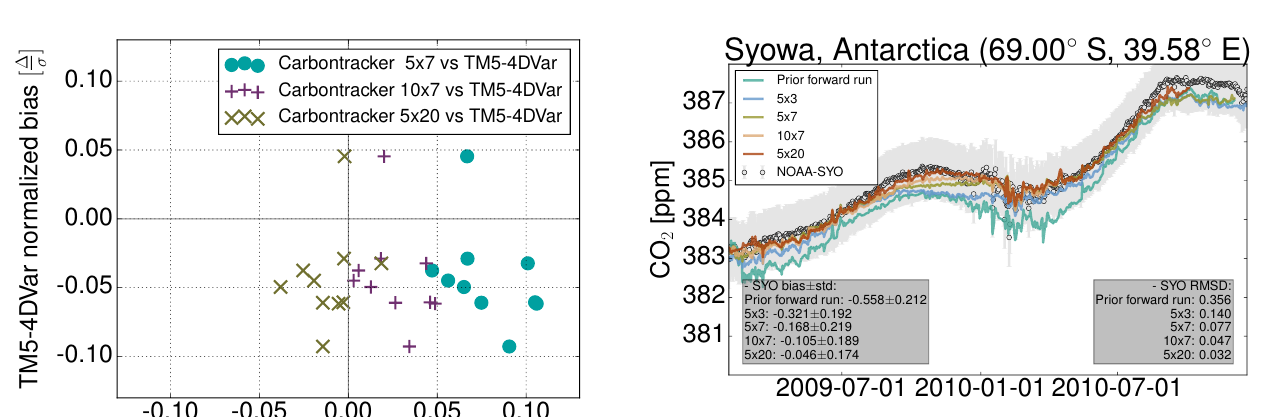
Figure 6. Time series of measured and modeled CO 2 concentra- tions at Syowa Station, Antarctica, for CarbonTracker runs with different lengths of the assimilation time window. The baseline run uses an assimilation window of 5 × 7 days. Color coding of shorter and longer assimilation windows follows the legend (lag × cycle in